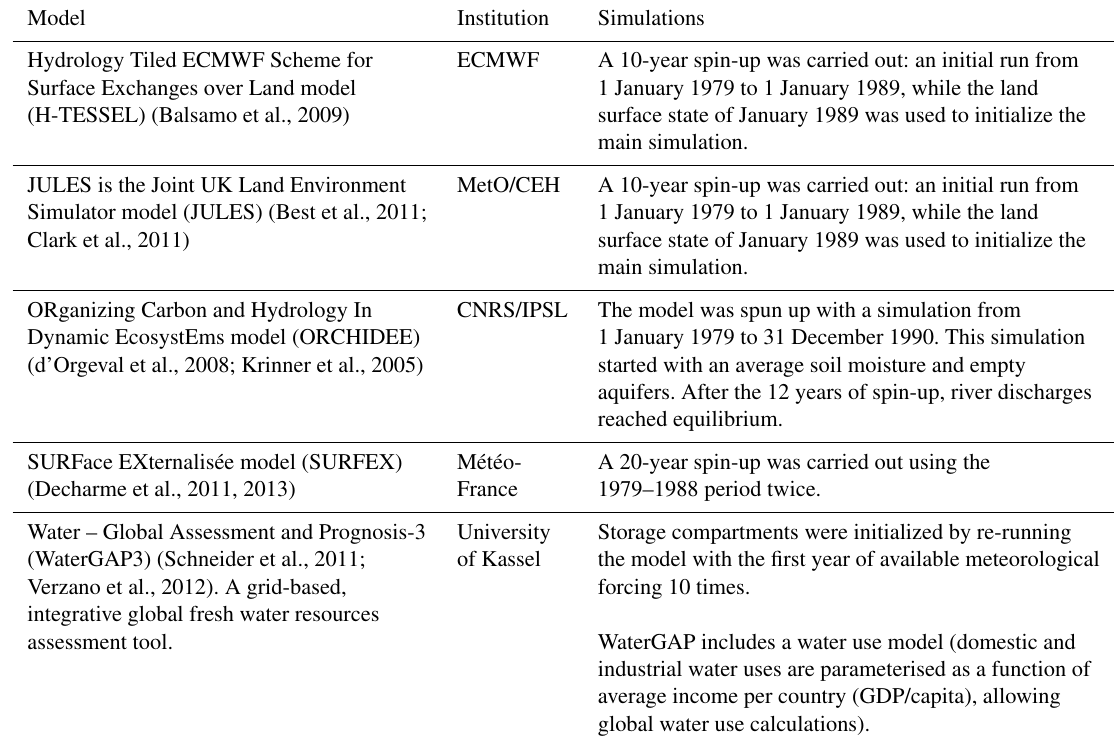
Table 3. Modelling systems details (Dutra et al., 2015; Nikolopoulos et al., 2016). Each model was driven using, as close as pos- sible, the same configuration: Global Water Resources Reanalysis 2 (WRR2, Arduini et al., 2017 and